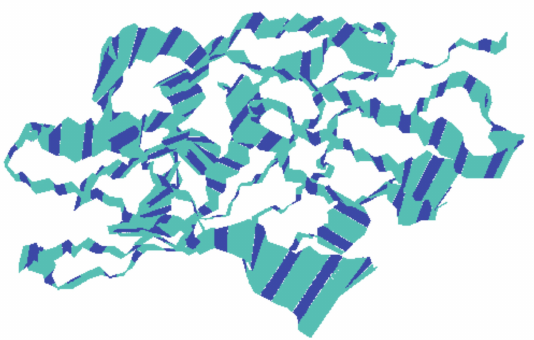
Figure 8. The motion of the backbone atoms of the protein receptor during simulation of the trajectory as calculated by principal component analysis. The width of the bands is proportional to